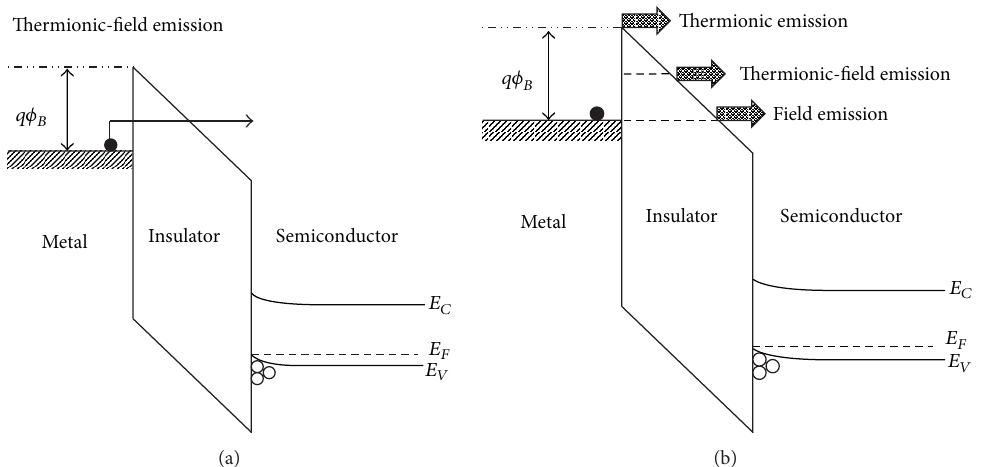
Figure 10: (a) Schematic energy band diagram of thermionic-field emission in metal-insulator-semiconductor structure. (b) Comparison of thermionic-field emission, thermionic emission, and field emission.